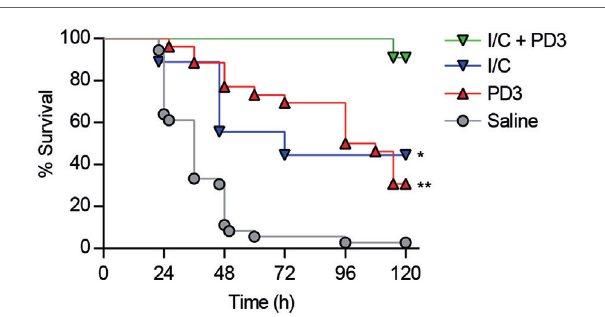
FigUre 8 | Additive effects of combined administration of CD6.PD3 and Imipenem/Cilastatin on mouse survival following cecal ligation and puncture (CLP)-induced sepsis. C57BL/6J mice were therapeutically infused 1 h post CLP with saline ( n = 31), CD6.PD3 (6 mg/kg intravenous; n = 25), Imipenem/ Cilastatin (I/C, 50 mg/kg/12h intraperitoneal; n = 9), or a combination of the two later ( n = 11). The average percent survival was analyzed over time for each group and compared to the I/C plus CD6.PD3 group using the long-rank t -test (* P < 0.05 and ** P < 0.01).